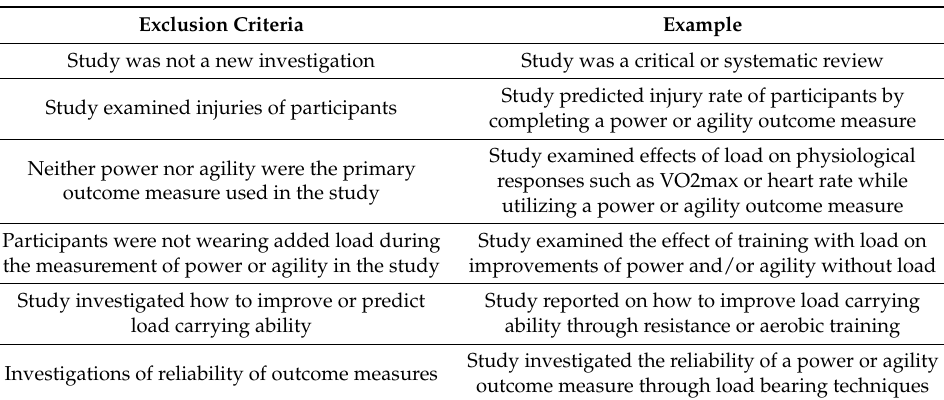
Table 2. Exclusion criteria and examples of excluded